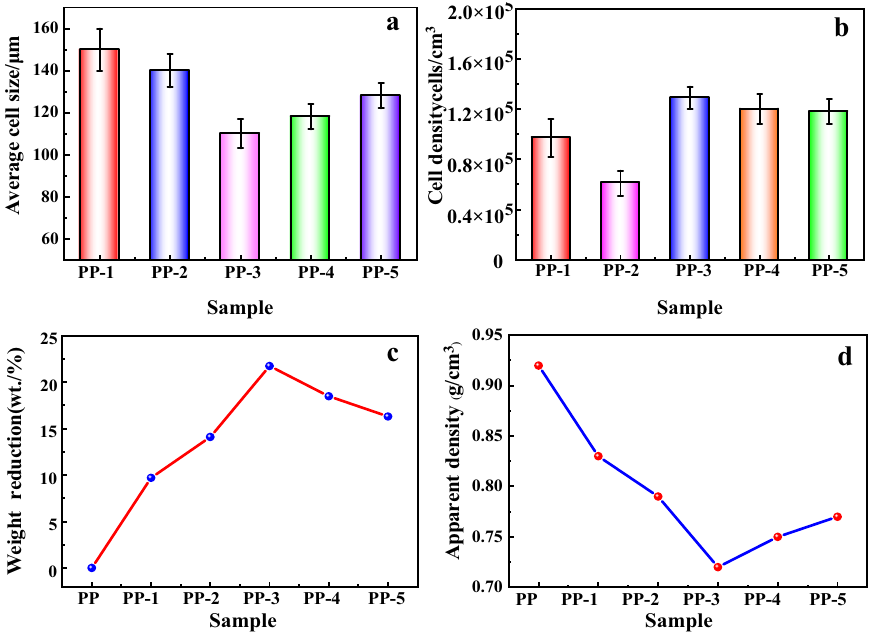
Figure 5: Cell parameters of the foamed PP composites: ( a ) average cell size, ( b ) cell density, ( c ) weight reduction, ( d ) apparent